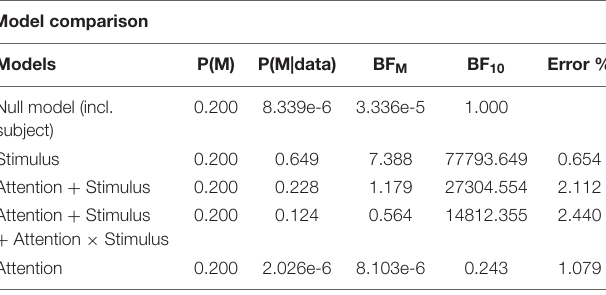
TABLE 2 | Bayes factors of Bayesian repeated measures ANOVA in the cross-modal